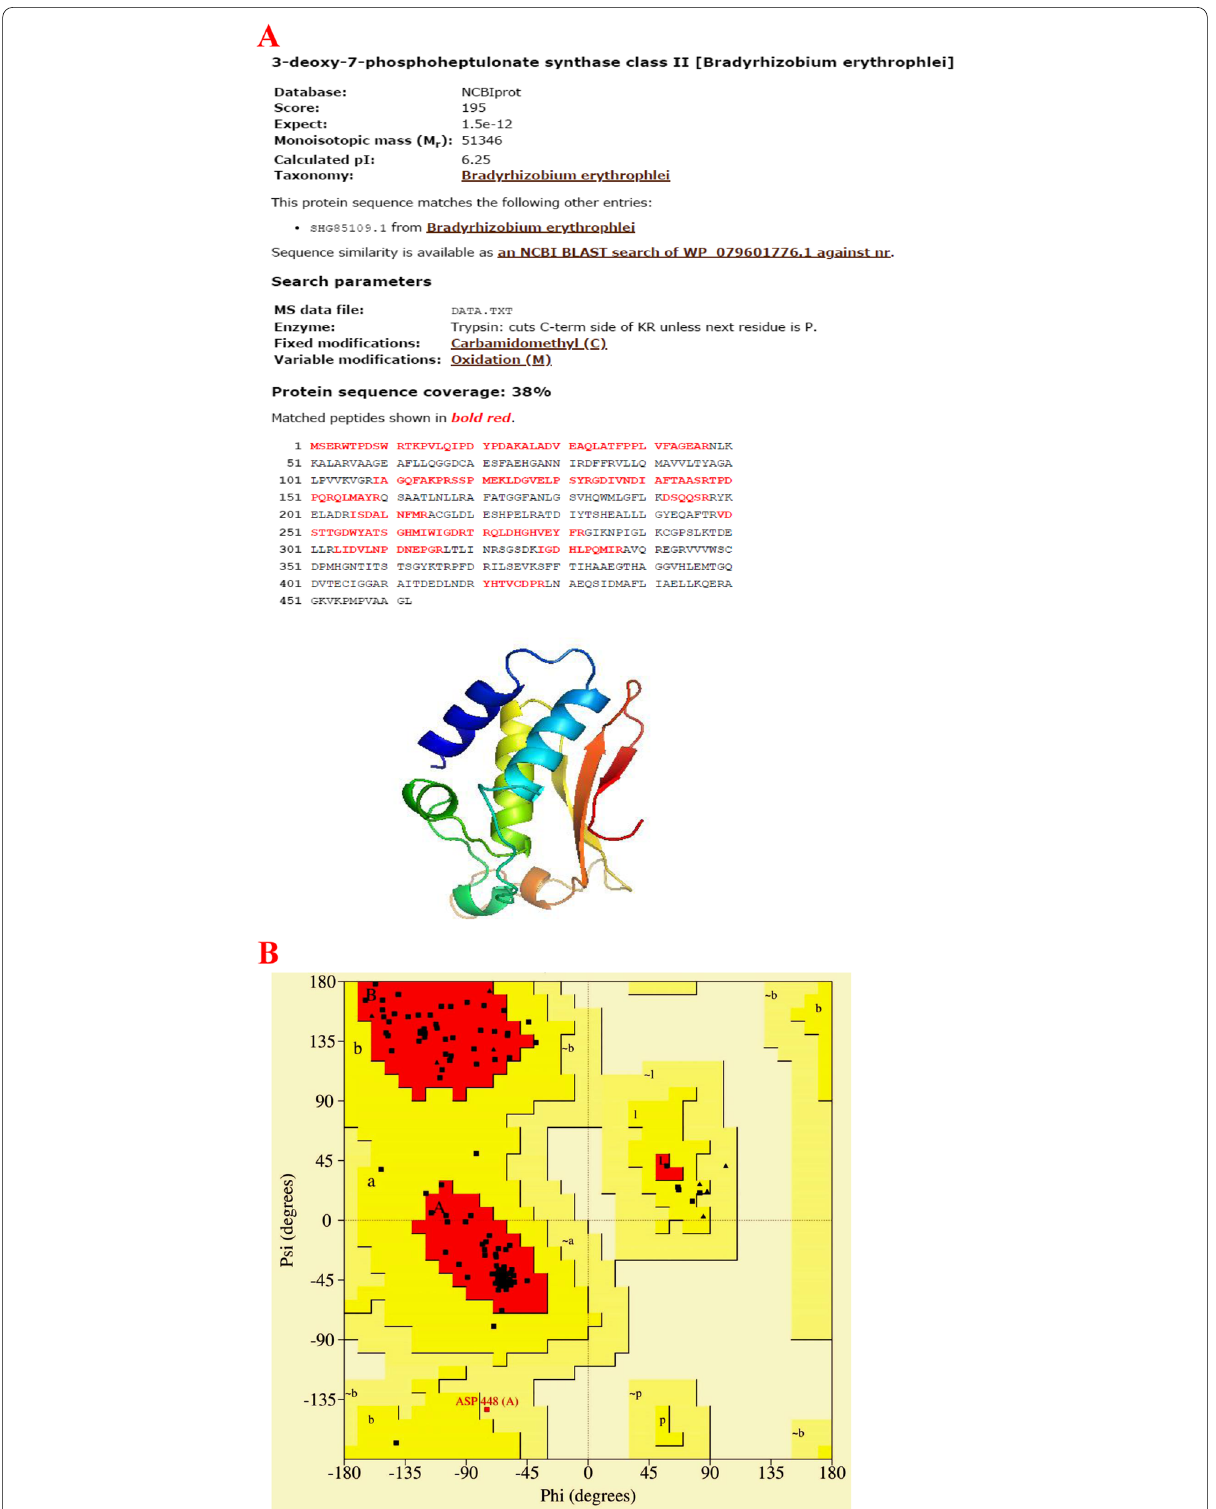
Fig. 6 NCBI database for MS data of purified protease of Bacillus thuringiensis ( A ); Ramachandran plot of homology-modeled structure ( B